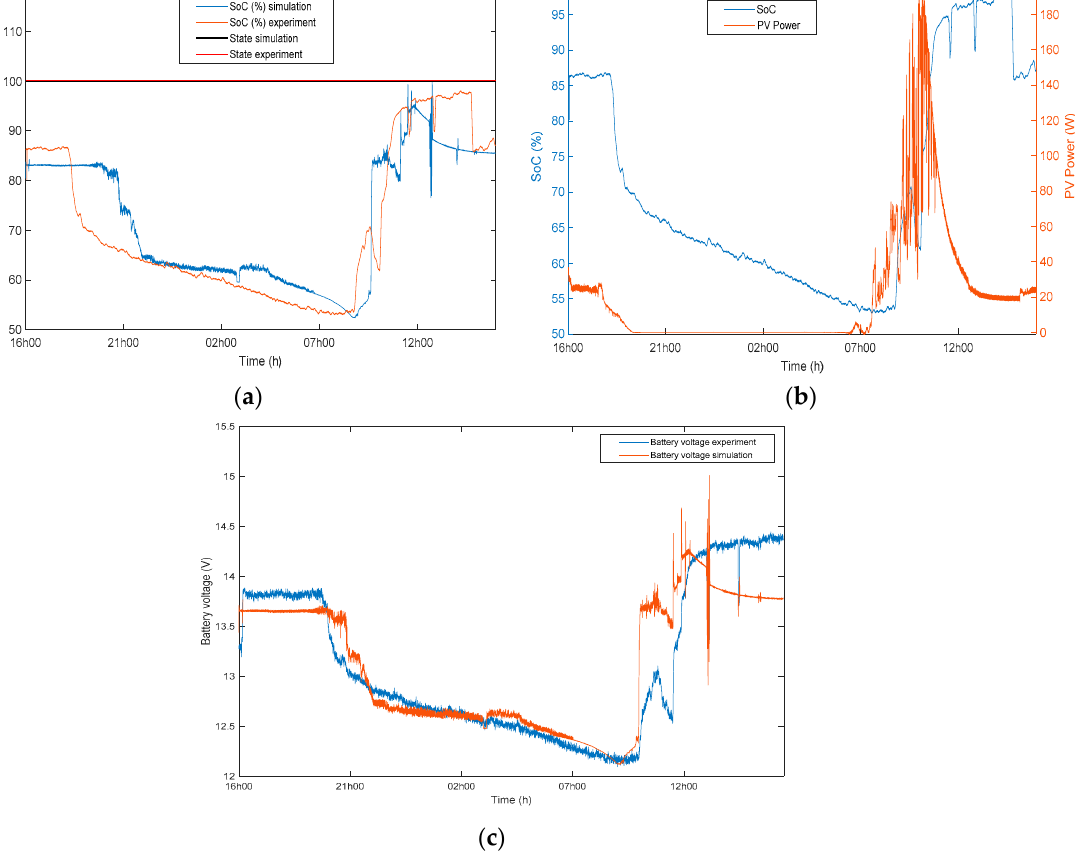
Figure 10. ( a ) The battery’s SoC and the state of the actuator from simulation and experiment; ( b ) The battery’s SoC and the PV power; ( c ) The simulation and experimental battery’s voltage.